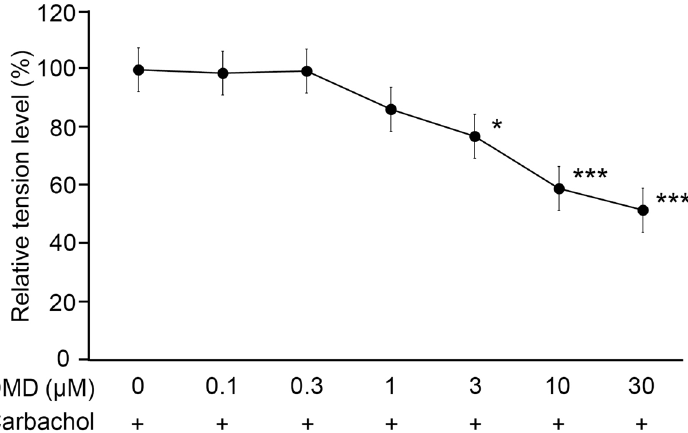
Figure 8. Effect of OMD on carbachol-induced contraction of ciliary muscle (CM). The effect of OMD on porcine CM contraction was measured using a force–length transducer. The relaxation responses of OMD were expressed relative to the maximum carbachol-induced contraction response. OMD inhibited CM contraction in a concentration-dependent manner. Data are presented as values relative to control values. Data are presented as the mean ± SE, n = 7. * P < 0.05 and *** P < 0.001 relative to baseline (Dunnett’s multiple comparisons